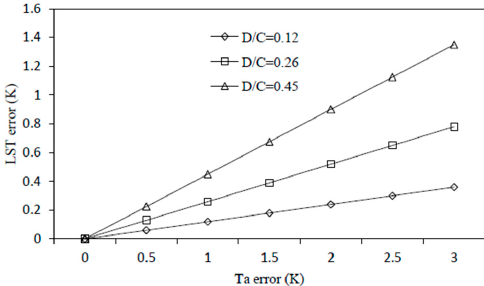
Figure 7. LST estimation error of mono-window algorithm as a result of the estimation error in near surface air temperature.